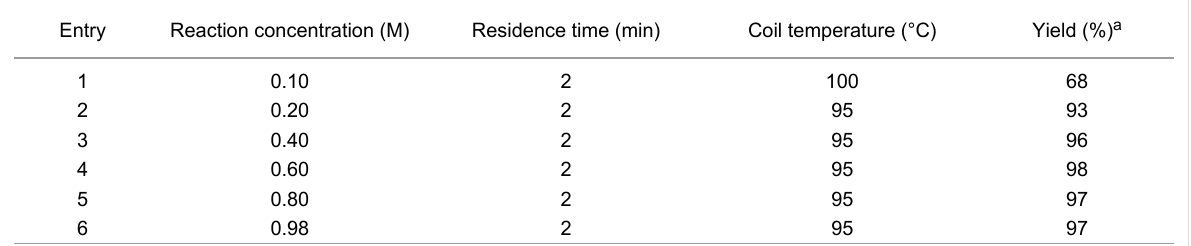
Table 1: Concentration screen for enamine